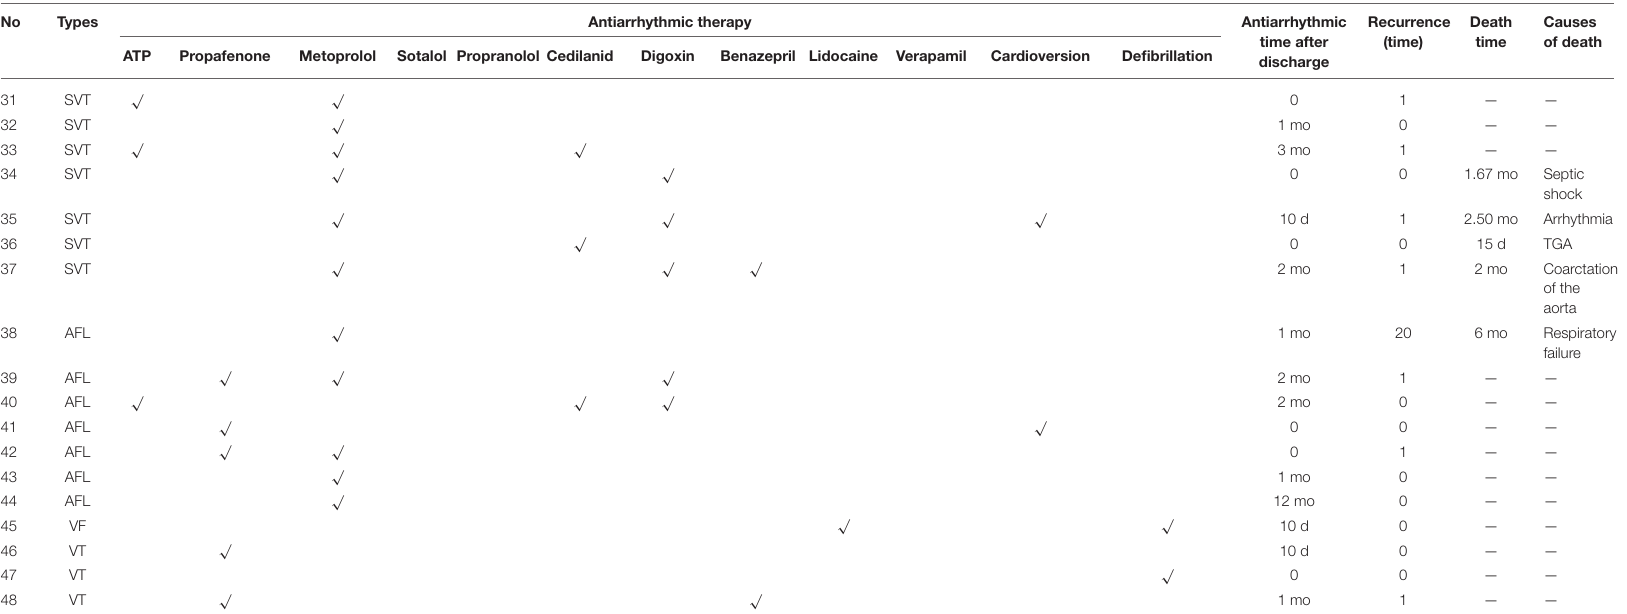
JR, junctional arrhythmia; PAC, premature atrial contraction; PVC, premature ventricular contraction; SVT, Supraventricular tachycardia; AFL, atrial flutter; VT, ventricular tachycardia; VF, ventricular fibrillation; AV, atrioventricular; ATP, adenosine triphosphate; TGA, complete transposition of the great artery. * Benign NA